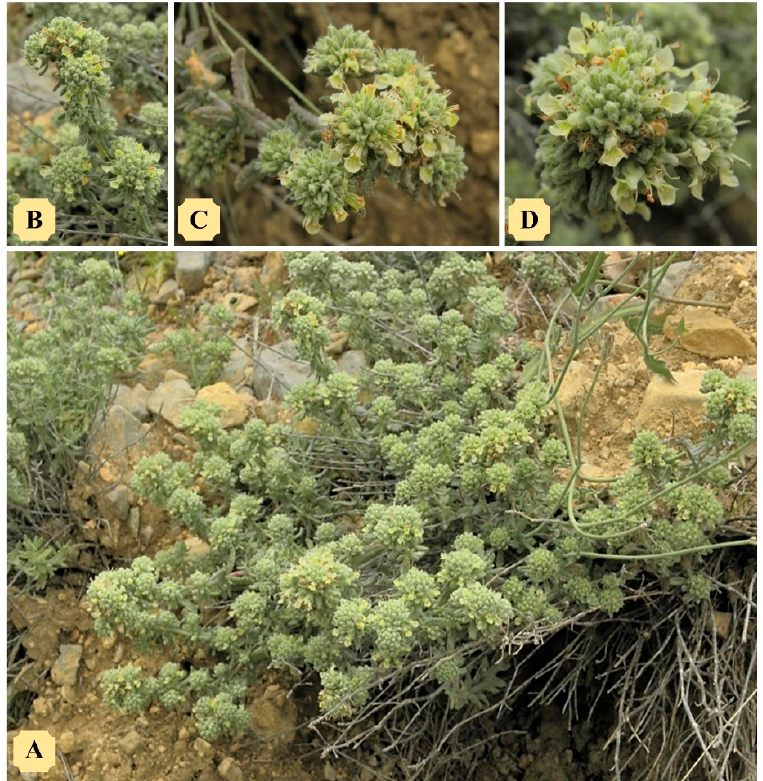
Figure 1. Tunisian Teucrium luteum subsp. flavovirens : ( A ) plant in its natural habitat; ( B ) leafy stem topped by the inflorescences of the year; ( C ) flowers gathered in pseudo-capitula at the top of the stems; ( D ) hemispherical inflorescence with yellow corolla flowers and exert stamens. Photos by Ridha El Mokni.